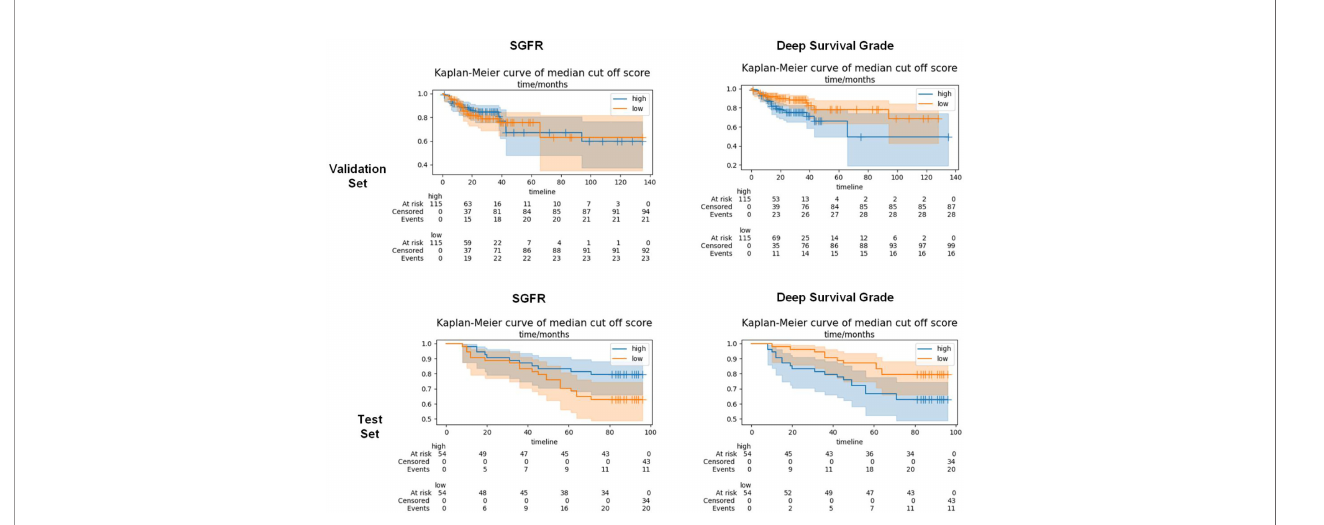
FIGURE 5 | Kaplan – Meier curves of semi-quantitative gland formation ratio (SGFR) and deep survival grade in validation set and test set. SGFR and deep survival grade were grouped into high group (higher than median) and low group (lower than median) and applied Kaplan – Meier curves in both validation set and test set.